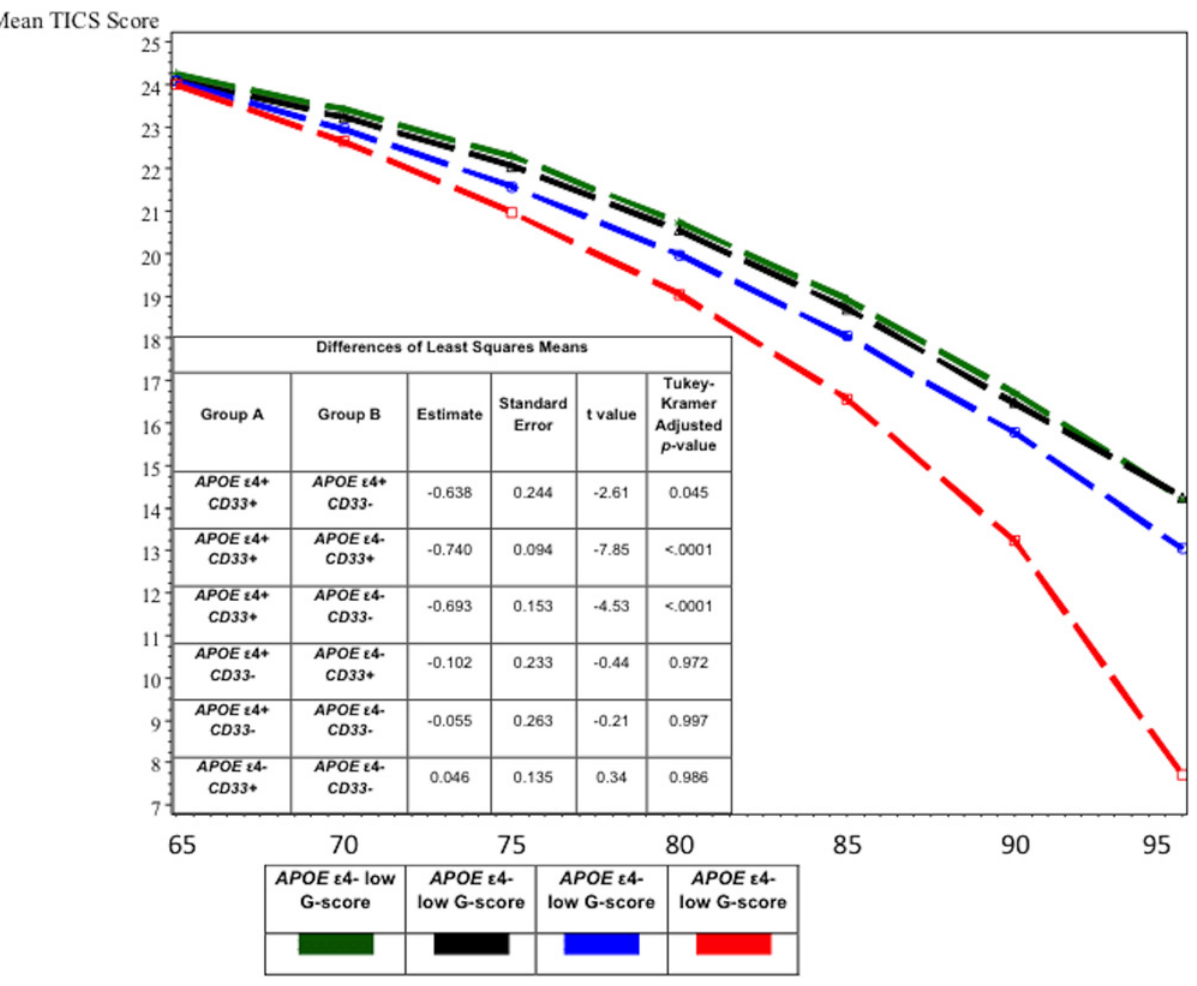
Fig 2. Mixed effects models for cognitive trajectories by APOE ε 4/G-score risk group. Abbreviations: TICS-m: Telephone interview for Cognitive Status-modified; high G-score: high genetic risk score; low G-score: low genetic risk score. Model included age, age 2 , sex, sex * age, education, education * age, and group * age. Corresponding model results for the four-level variable and interaction terms are presented in Table